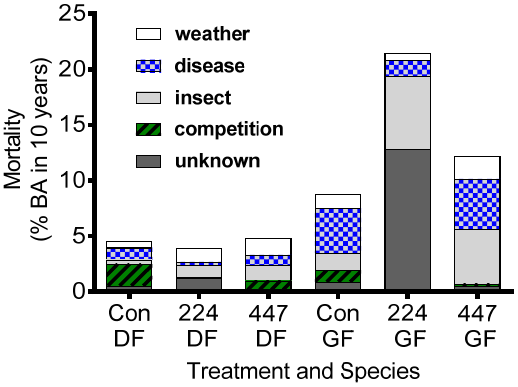
Figure 9. The causes of ten-year basal area mortality of Douglas-fir and grand fir treated with either 224 or 447 kg N ha − 1 and compared with unfertilized controls. Data are from 30 mature (average 65 year-old) Douglas-fir dominated (80% basal area) stands in Idaho, Montana, Oregon and Washington including five parent material classes and three vegetation series representing the range of regional productivity. All stands were recently thinned or were naturally well spaced. Initial basal area averaged 36 ± 10 m 2 ha − 1